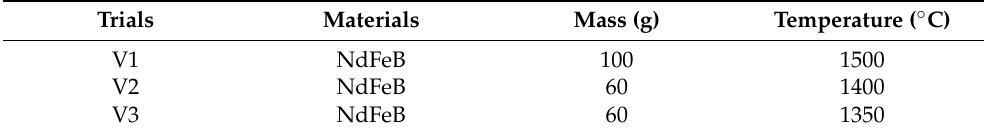
Table 6. Completed smelting experiment in argon.